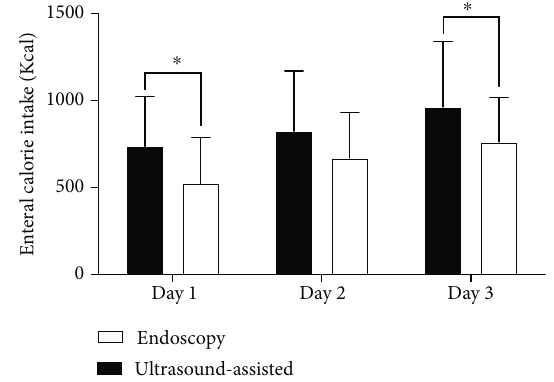
Figure 1: The daily amount of energy intake for the fi rst three days after nasojejunal tube placement. All patients were divided into ultrasound-assisted (dark boxes) and endoscopy (light boxes) groups. The ultrasound-assisted group showed a much higher amount of calorie intake measured by the proportion of the target at each day ( ∗ P < 0 : 05 ).